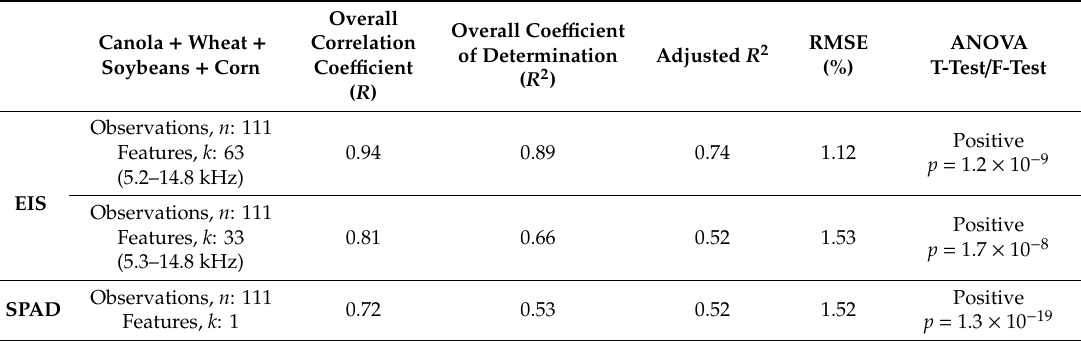
Figure 7. Plots of ( a ) soil ‐ plant analyses development (SPAD) reading versus LNC; ( b ) number of observations versus value of residuals; and ( c ) actual LNC versus predicted LNC for canola+wheat+soybeans+corn using SPAD. The extracted coefficient of determination ( R 2 ) is 0.53 and the corresponding overall correlation coefficient ( R ) is 0.72. Table 3. Comparative regression results between EIS and SPAD for the plant species with nitrogen concentrations using combined